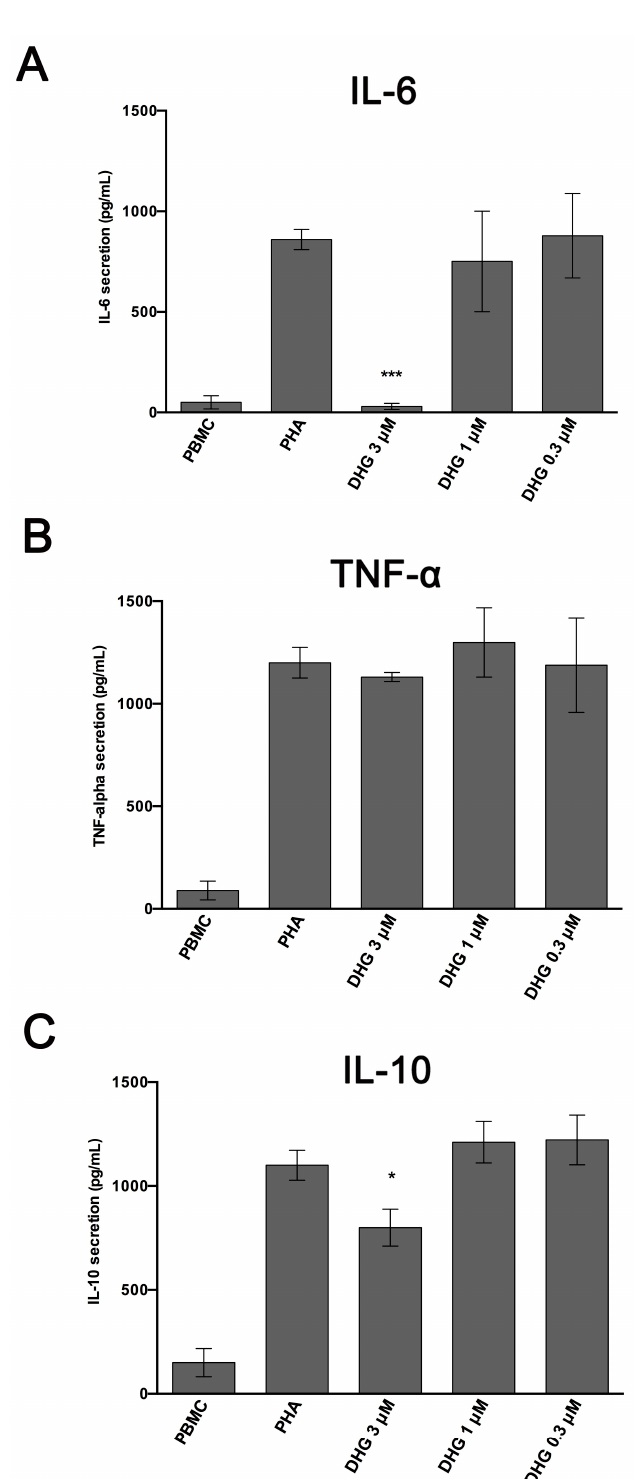
Figure 3. Cytokine secretion profile of DHG-treated PBMC. PBMC of healthy donors ( n = 4) were activated with PHA (1.5%) for 24 h in the presence and in the absence of DHG at the indicated concentrations. Unstimulated cells are included as control (PBMC) in the figure. Supernatants were harvested and the concentrations of interleukin 6 (IL-6) ( A ), tumor necrosis factor-alpha (TNF- α ) ( B ) and IL-10 ( C ) determined by ELISA immunoassay. Values reported refer to mean ± SD of four different donors. Statistical analyses are reported (ANOVA; * p < 0.05; *** p < 0.001).